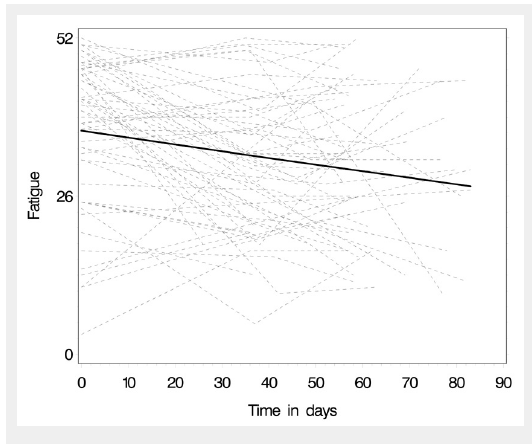
Predicted trend of fatigue over the three measurement points: thin lines represent patients’ individual trajectories, the thick line the average group trend. Lower scores indicate increase of